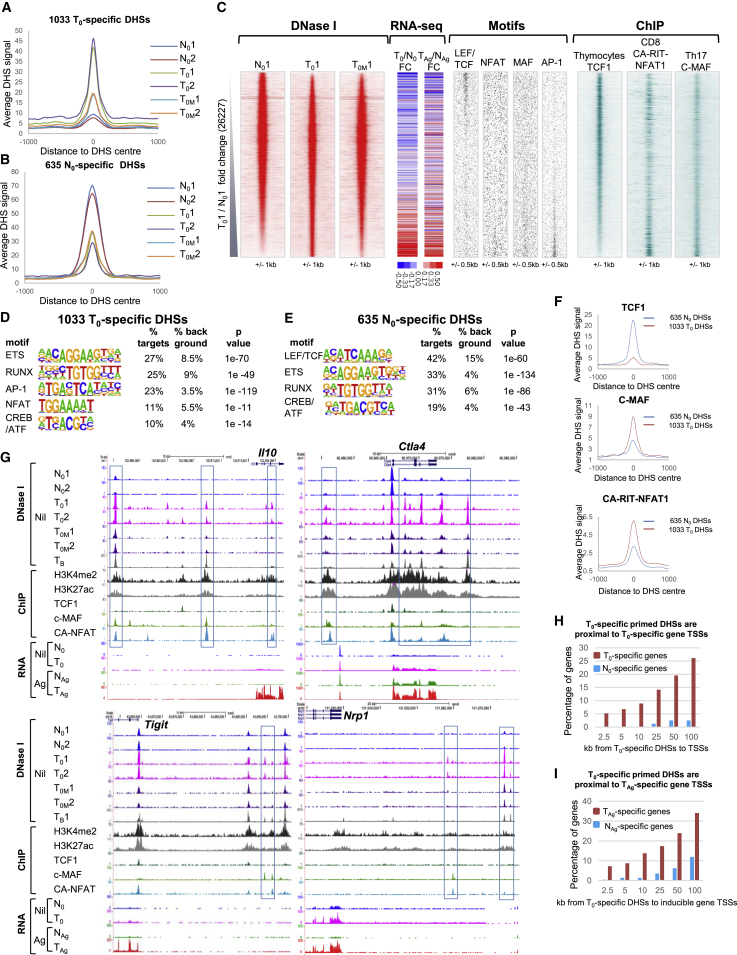
DNase-Seq Analyses of Open Chromatin in Naive and Tolerized T Cells(A and B) Average DHS signal at the 1,033 T0-specific DHSs (A) and at the 635 N0-enriched DHSs (B) in the replicate N0, T0, and T0M samples.(C) DNase-seq sequence tag density plots showing all 26,227 peaks detected in replicate 1 of T0 and N0 ordered by increasing fold change (FC) of sequence tag count for T0 compared with N0. Alongside is the FC in mRNA level for the closest gene to the DHSs as ranked in the density plots. The FC is shown between T0 and N0 (left), and TAg is compared with NAg (right). The locations of TF consensus binding motifs within the same DHSs are shown alongside for AP-1, NFAT, MAF, and LEF family proteins. Plotted alongside are published TF binding data from ChIP-seq analyses for TCF1 in thymocytes (Dose et al., 2014), c-MAF in Th17 cells (Ciofani et al., 2012), and ectopic CA-RIT-NFAT1 in CD8 T cells (Martinez et al., 2015).(D and E) HOMER de novo identification of TF motifs enriched in the 1,033 T0-specific DHSs (D) and the 635 N0-specific DHSs (E).(F) Average ChIP signal at the 1,033 T0-specific DHSs and 635 N0-specific DHSs for TCF1, c-MAF, and CA-RIT-NFAT1.(G) UCSC Genome Browser tracks showing DNase-seq data from replicate samples of non-stimulated naive cells (N0), non-stimulated tolerant cells (T0), and tolerant cells 3 weeks after the final dose of peptide (T0M), plus published DNase-seq data for CD4 T blast (TB) cells (Bevington et al., 2016). Published ChIP-seq data are shown for the TFs TCF1, c-MAF, and CA-RIT-NFAT1 and the histone modifications H3K27ac and H3K4me2 in TB cells. Representative RNA-seq data from one of three replicates are also shown for resting and in vivo peptide-stimulated naive and tolerant cells (0 and Ag).(H and I) Bar graphs showing the percentage and proximity of genes that are preferentially induced in T0 or N0 (H) and TAg or NAg (I), which are found within 100 kb of the 1,033 T0-specific DHSs.